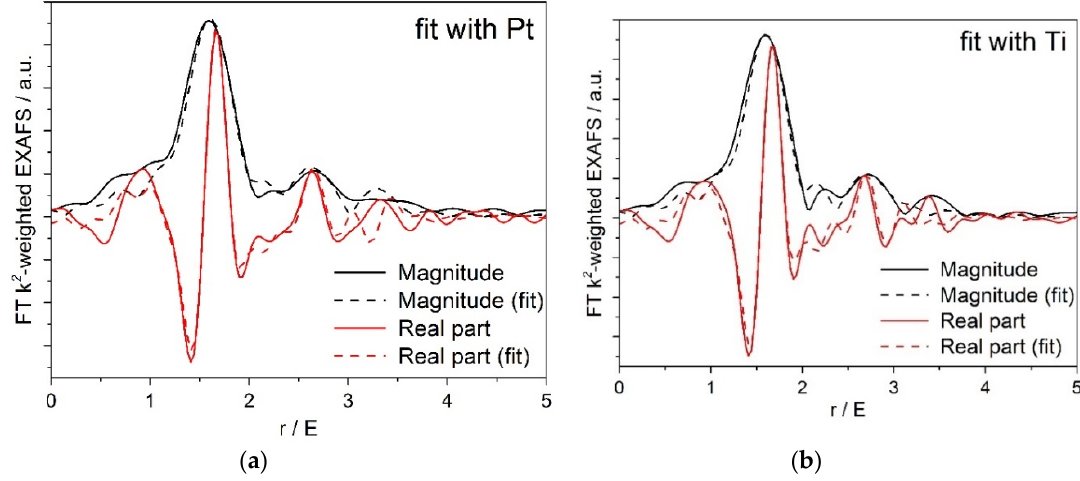
Figure A2. ( a ) Pt/Ti-P25-400 EXAFS fit to a structural model containing O and Pt nearest neighbors; ( b ) Pt/Ti-PLA-400 EXAFS fit to a structural model containing O and Pt nearest neighbors.